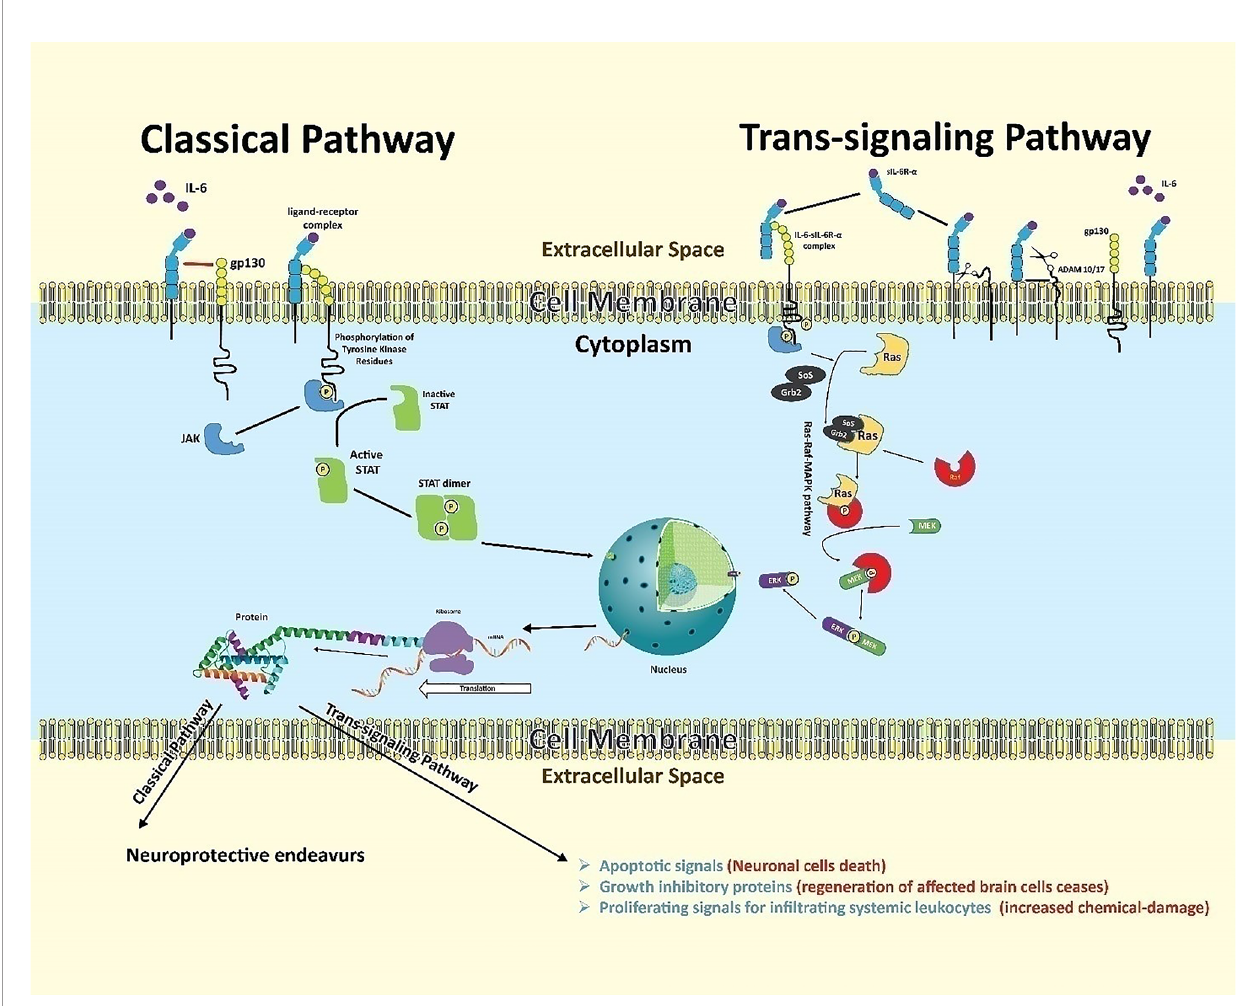
FIGURE 4 | Neuroin fl ammation downstream of IL-6 in stroke. IL-6 binds its receptor and proceeds two separate but related pathways: the classical and trans- signaling pathways. The classical pathway begins when IL-6 binds with IL-6R- a chain subunit assisted by gp130, an intra-cellular signal transducer. This binding allows intracellular, receptor-associated JAKs to phosphorylate each other on respective tyrosine domains. Phosphorylated JAKs further phosphorylate related tyrosine residues on the receptor, creating binding sites for proteins possessing SH2 domains. Cytoplasmic STATs then bind to these SH2 domains to be phosphorylated by respective JAKs, making them dissociate from the receptor. The dissociated STATs form dimers, which act as transcription factors. The dimers translocate to the cell nucleus to induce gene expression for subsequent protein signaling outcomes. STATs may also be tyrosine-phosphorylated directly by receptor tyrosine kinases - but since most receptors lack built-in kinase activity, JAKs are usually required for signaling. The trans-signaling pathway begins when IL- 6 ligands with sIL-6R- a in the extracellular matrix. The high af fi nity drives this complex to bind with gp130 expressed overly on glial and neuronal cells following ischemic insult. This trio-binding results in the activation of intracellular tyrosine-associated JAKs. Phosphorylated tyrosine-sited allow the adaptor proteins (SoS and Grb-2) to bind and convert inactive cytoplasmic RAS to an active one, initiating a series of phosphorylations of a variety of molecules like Raf, MEK, and ERK. The activated ERK acts as a transcriptional factor. It enters the nucleus to express targeted genes for in fl ammatory protein